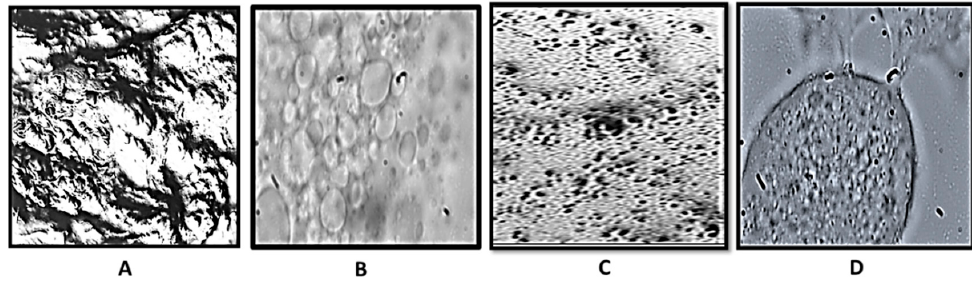
Figure 2. Optical microscopic images of blank (( A ):10× and ( B ):100×) and probiotic-loaded formula- tion (( C ):10× and ( D ):100×) .